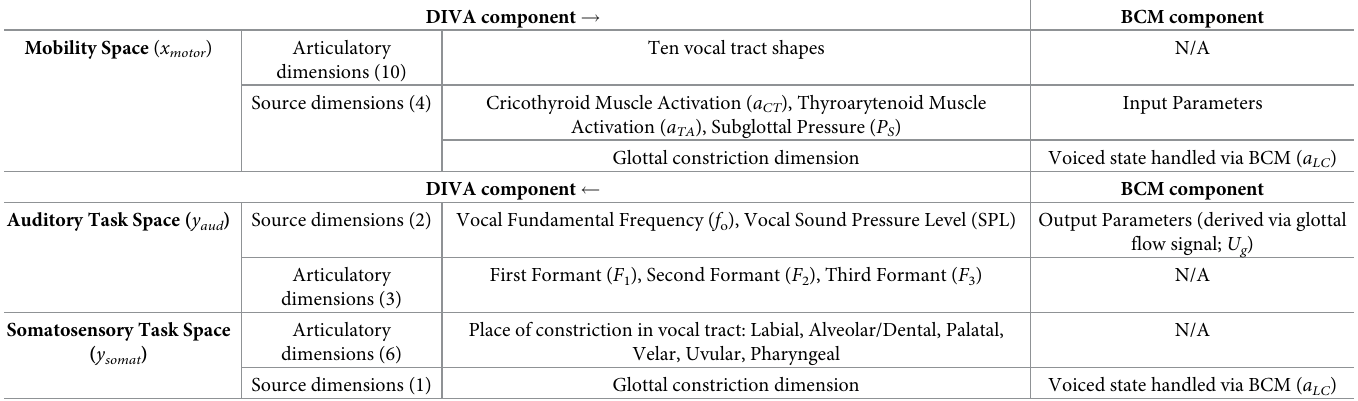
Table 1. LaDIVA Model